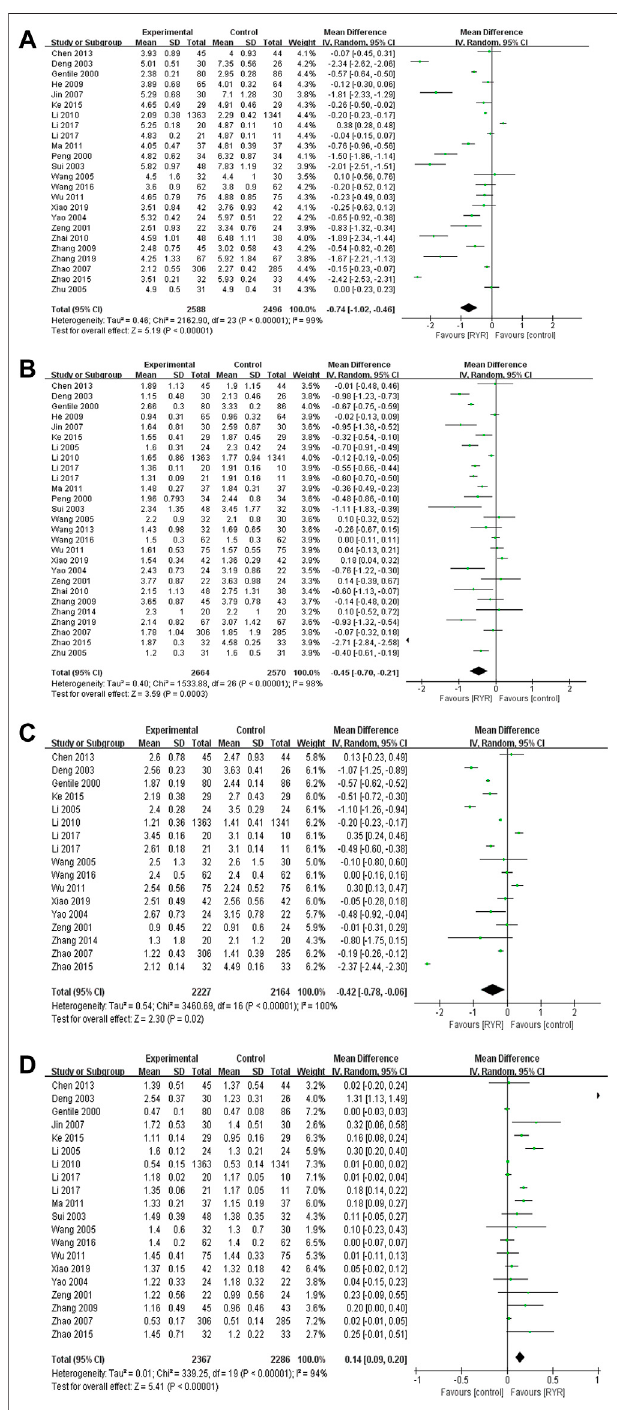
FIGURE 4 | Forest plots of (A) TC, (B) TG, (C) LDL − C, and (D) HDL − C.